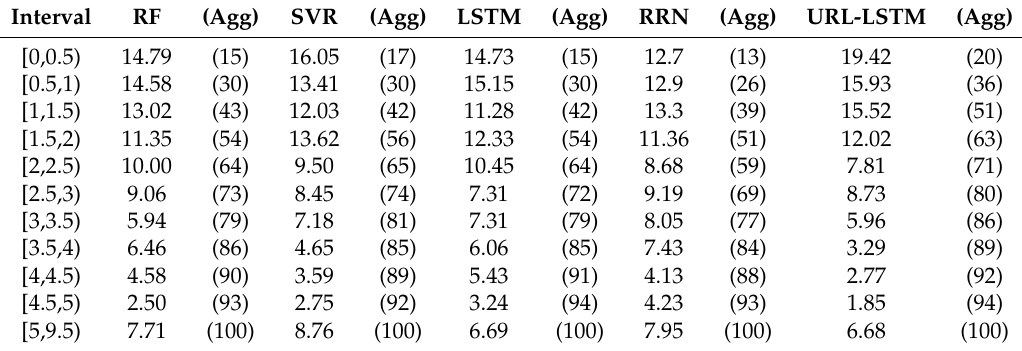
Figure 12. The histogram of MRE in coarse-grained power consumption prediction. Table 4. The MRE (%) distribution in coarse-grained power consumption